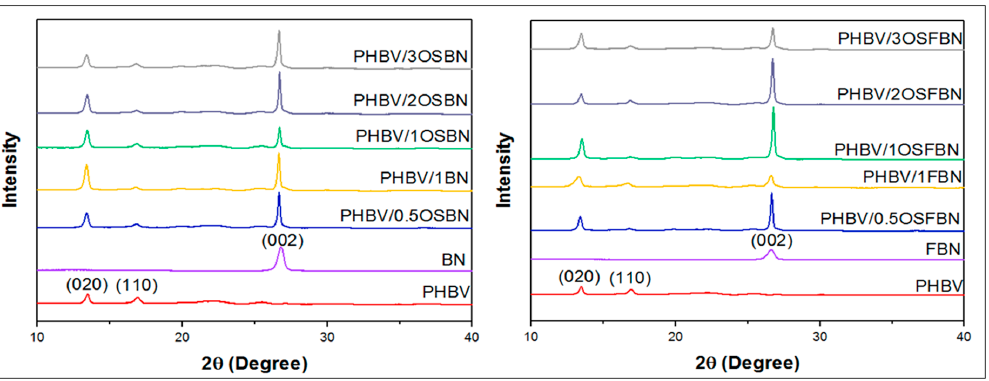
Figure 3. XRD patterns of neat PHBV, BN, FBN and nanocomposites.